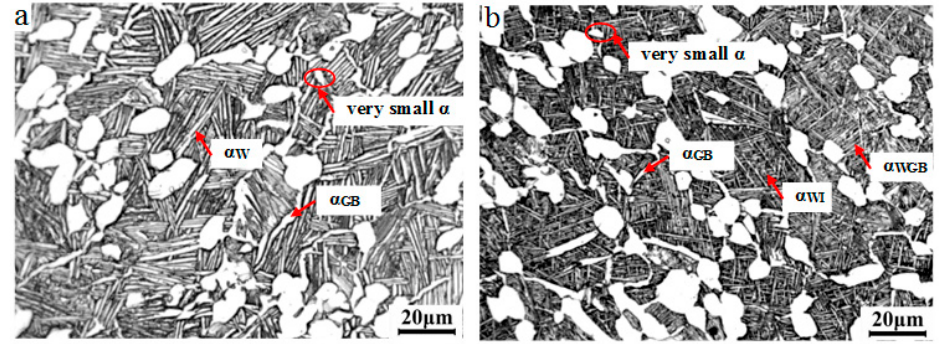
Figure 2. Optical micrographs of TA15 alloy after near- β forging and low-temperature annealing: